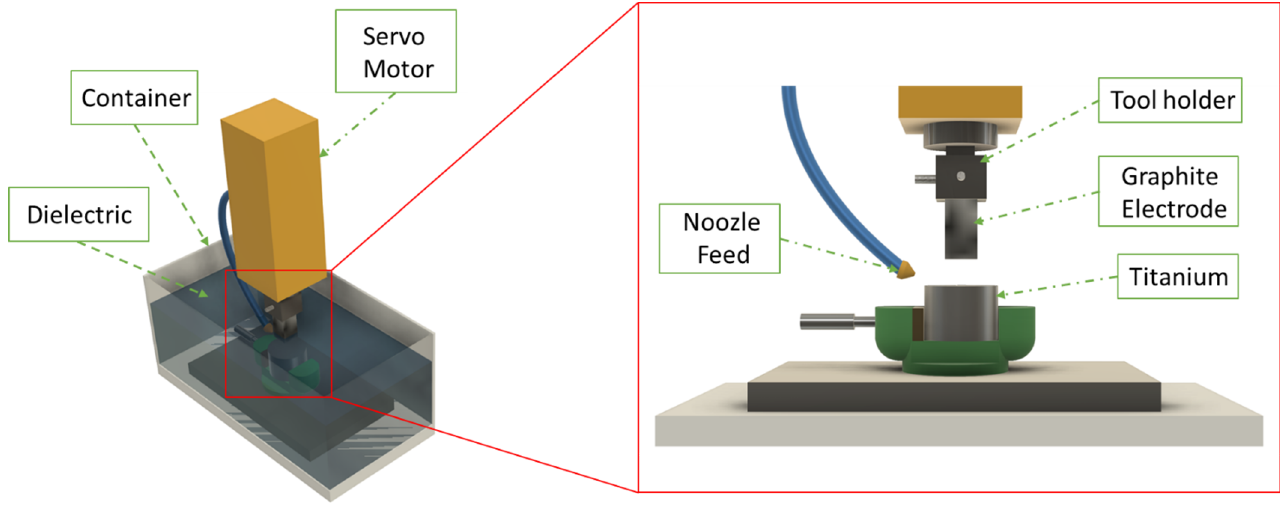
Figure 2. Graphical representation of EDM setup.